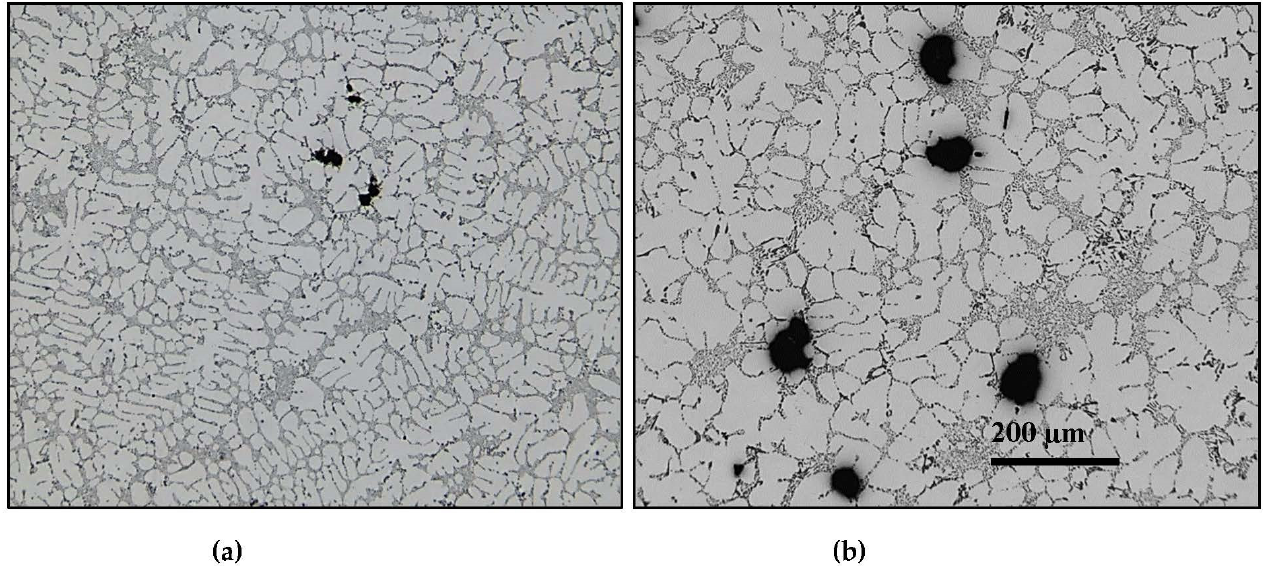
Figure 12. Optical micrographs of 319 alloy obtained at ( a ) solidification rate ~8 °C/s and ( b ) solidification rate ~0.35 °C/s.